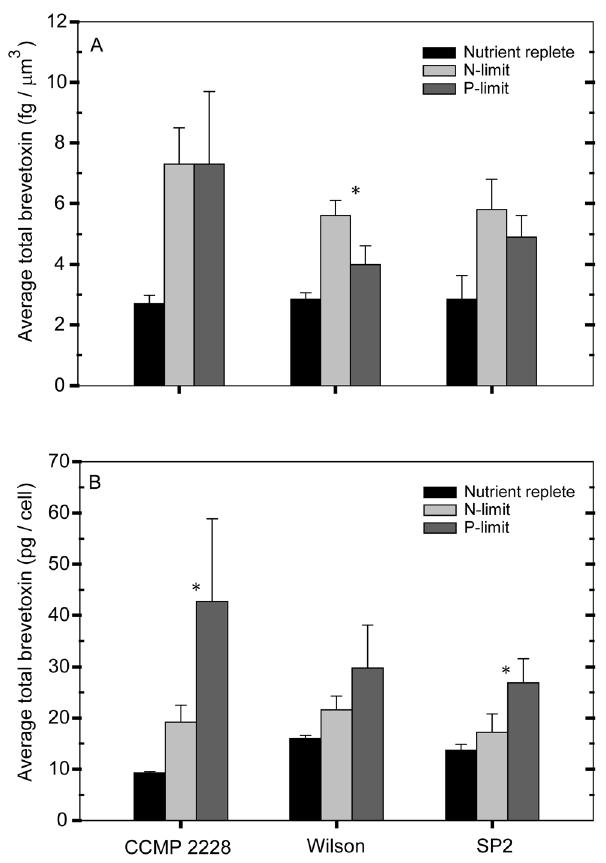
Figure 8. Comparison of N- and P-limitation studies of Karenia brevis . Average total brevetoxin normalized (A) to cell volume (fg/ m m 3 ), and (B) to average total brevetoxin per cell (pg/cell) in nutrient-replete and P-limited cultures in the present study and nutrient-replete and N- limited cultures in a previous study [20]. Average N- and P-limitation values were calculated using data measured after the onset of growth limitation (see methods). Data are presented for the three Karenia brevis strains common to both studies. Statistical differences were assessed using a Kruskal-Wallis one-way ANOVA (p , 0.05). All P-limitation treatments were significantly different from the control values. All of the N-limited treatments, with the exception of the Wilson and SP2 strains in panel B, were significantly different from the controls. An asterisk ( * ) denotes when the N- and P-limitation toxin values for a particular strain were significantly